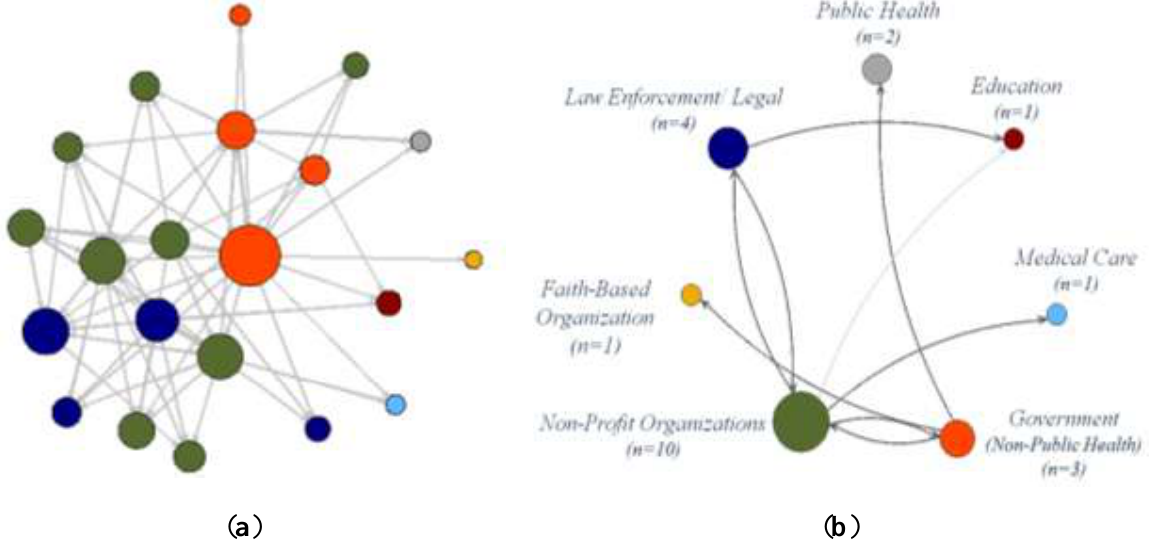
Figure 1. ( a ) Traditional network graph of interactions within a public health collaborative (PHC). ( b ) Reduced network graph of inter-organizational